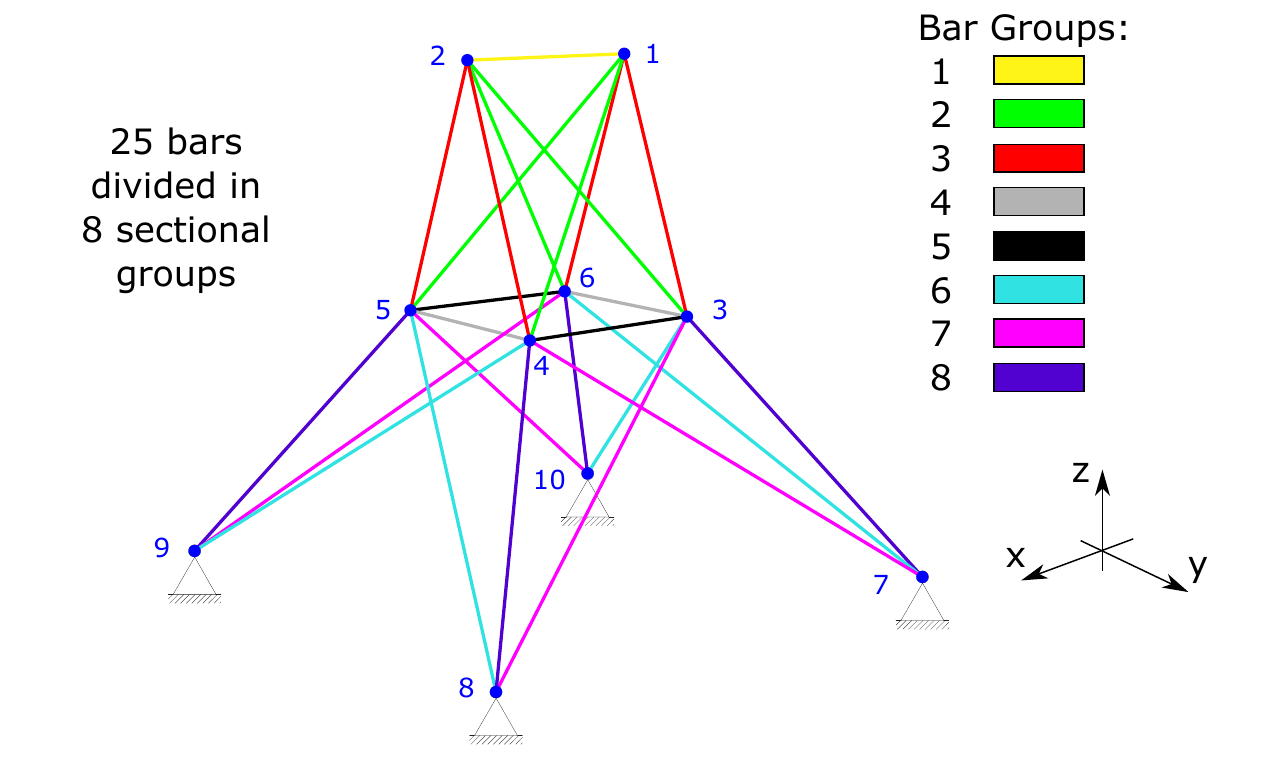
Figure 8. Graphical representation of the 8 bar groups in which are collected all the members of the 25 bar truss design optimization problem. Table 3. Twenty-five bar truss design example: results comparisons for 100 runs among the enhanced multi-strategy PSO ( PSO-MS ), the PSO with static penalty ( PSO-Static ), and the PSO with dynamic penalty ( PSO-Dynamic ) and